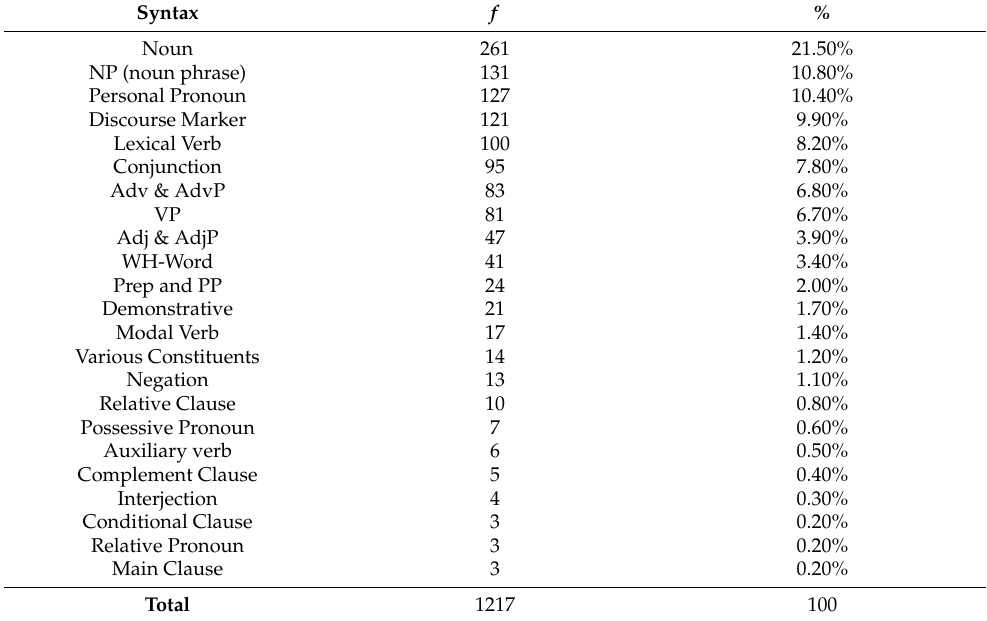
Table 4. Overview of syntactic categories of the